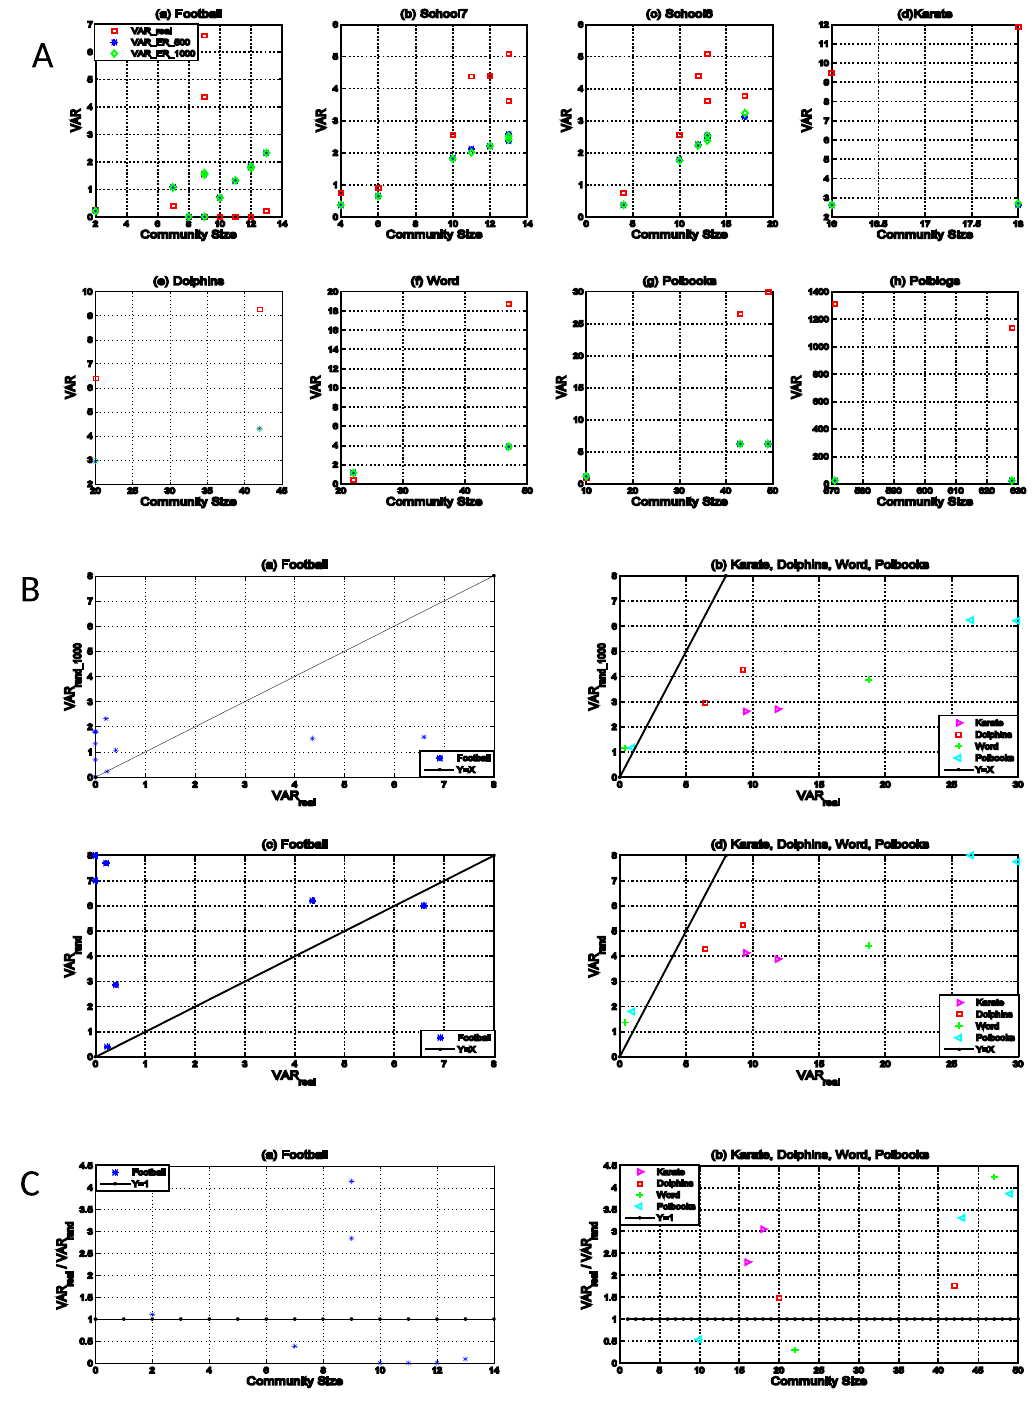
Figure 3. VAR real ’s, VAR rand ’s and variance ratios of communities in real world networks with known community structures. Here VAR_real is the VAR of a community. VAR rand ’s in panel A are from simulation, averaged over M randomly generated ER networks with the same number of nodes N and average node degree, where M takes values of 500 and 1,000 and denoted as VAR_ER_ 500 and VAR_ER_ 1,000, respectively. As shown, VAR_ER_ 500 is almost the same as VAR_ER_ 1,000, suggesting that the approximation of VAR rand via simulation is stable and efficient. Panel B shows the results from simulation and approximation VAR rand = 〈 k 〉 . Simulation with M = 1,000 is used for B ( a ) and B ( b ) and approximation for B ( c ) and B ( d ). The line in each diagram is the bound of VAR rand = VAR real . The ratios of p = VAR real / VAR rand are shown in panel C, where VAR rand ’s are from simulation with M = 1,000 as in B. The x-axes of the figures correspond to community sizies, which are ordered from small to